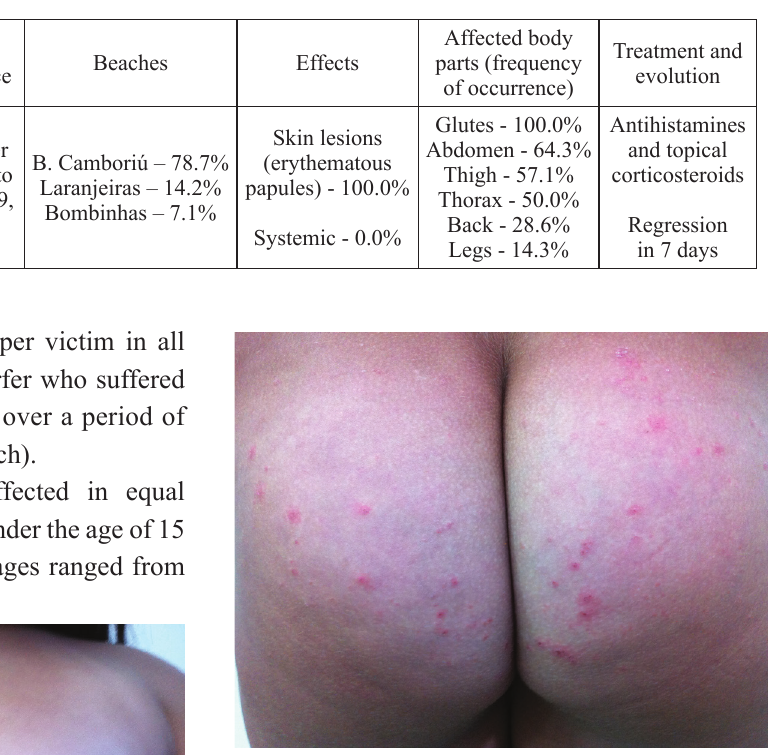
Summary of the results of the occurrence of fourteen cases of Seabather’s eruption (SBE) on